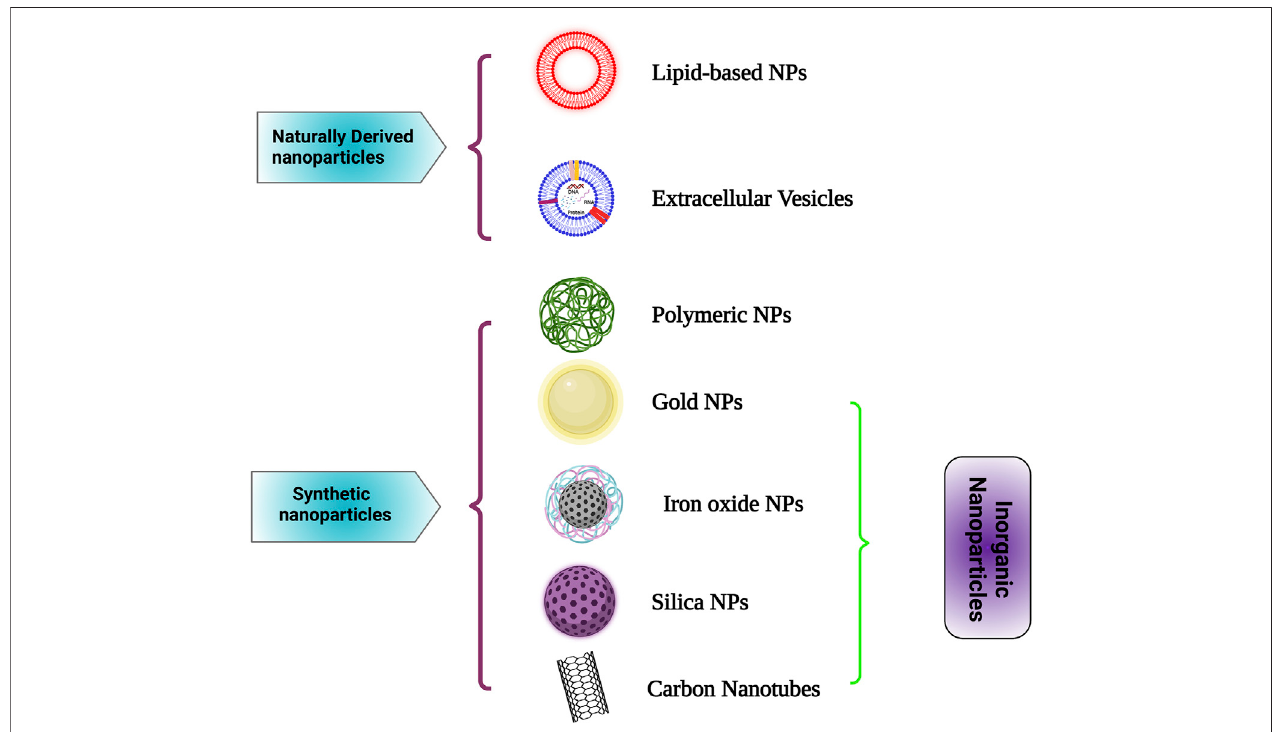
FIGURE1| DifferentnanocarriersusedincancerimmunotherapysuchasLipid-basedNPs,ExtracellularVesicles,PolymericNPs,GoldNPs,IronoxideNPs,Silica NPs and Carbon Nanotubes for cancer immunotherapy are depicted here. Created with Biorender.com.